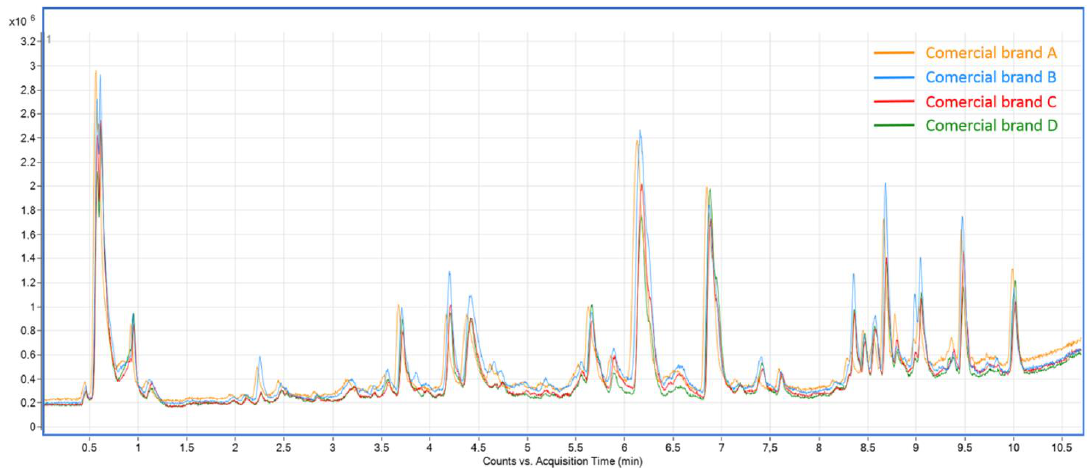
Figure 1. Total ion chromatograms (TIC) of rosemary infusions from different brands, analyzed by UHPLC-ESI-QTOF- MS/MS.